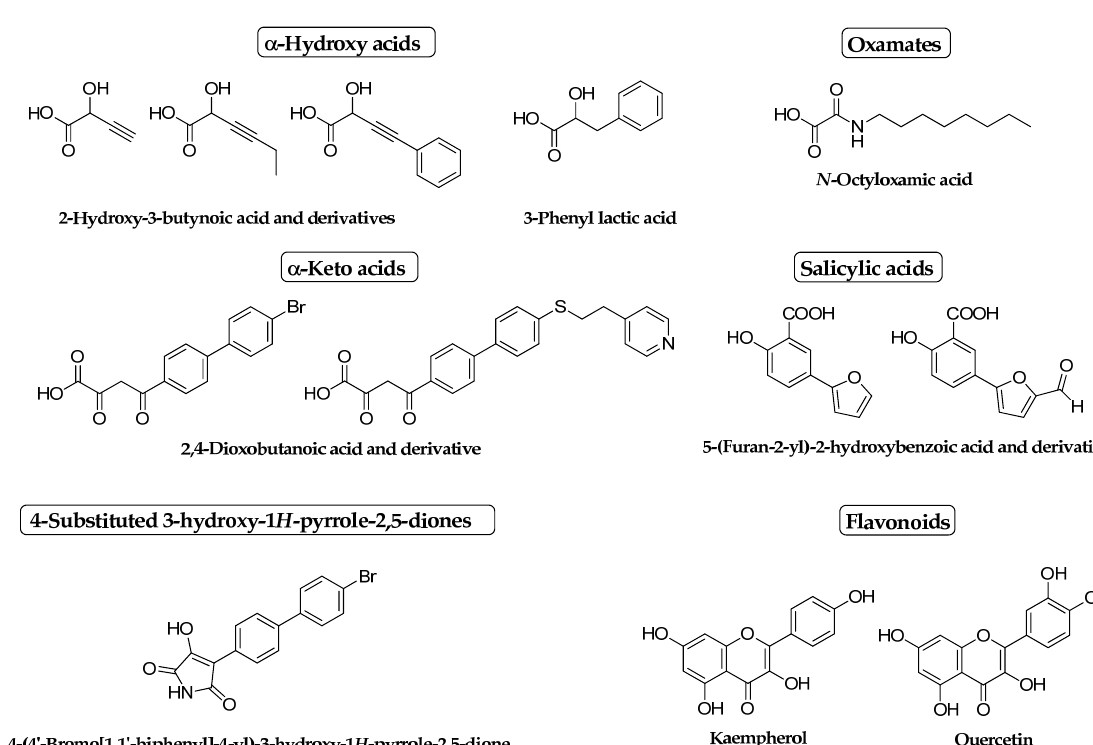
Figure 5. Structure of some known GOi´s belonging to different structural